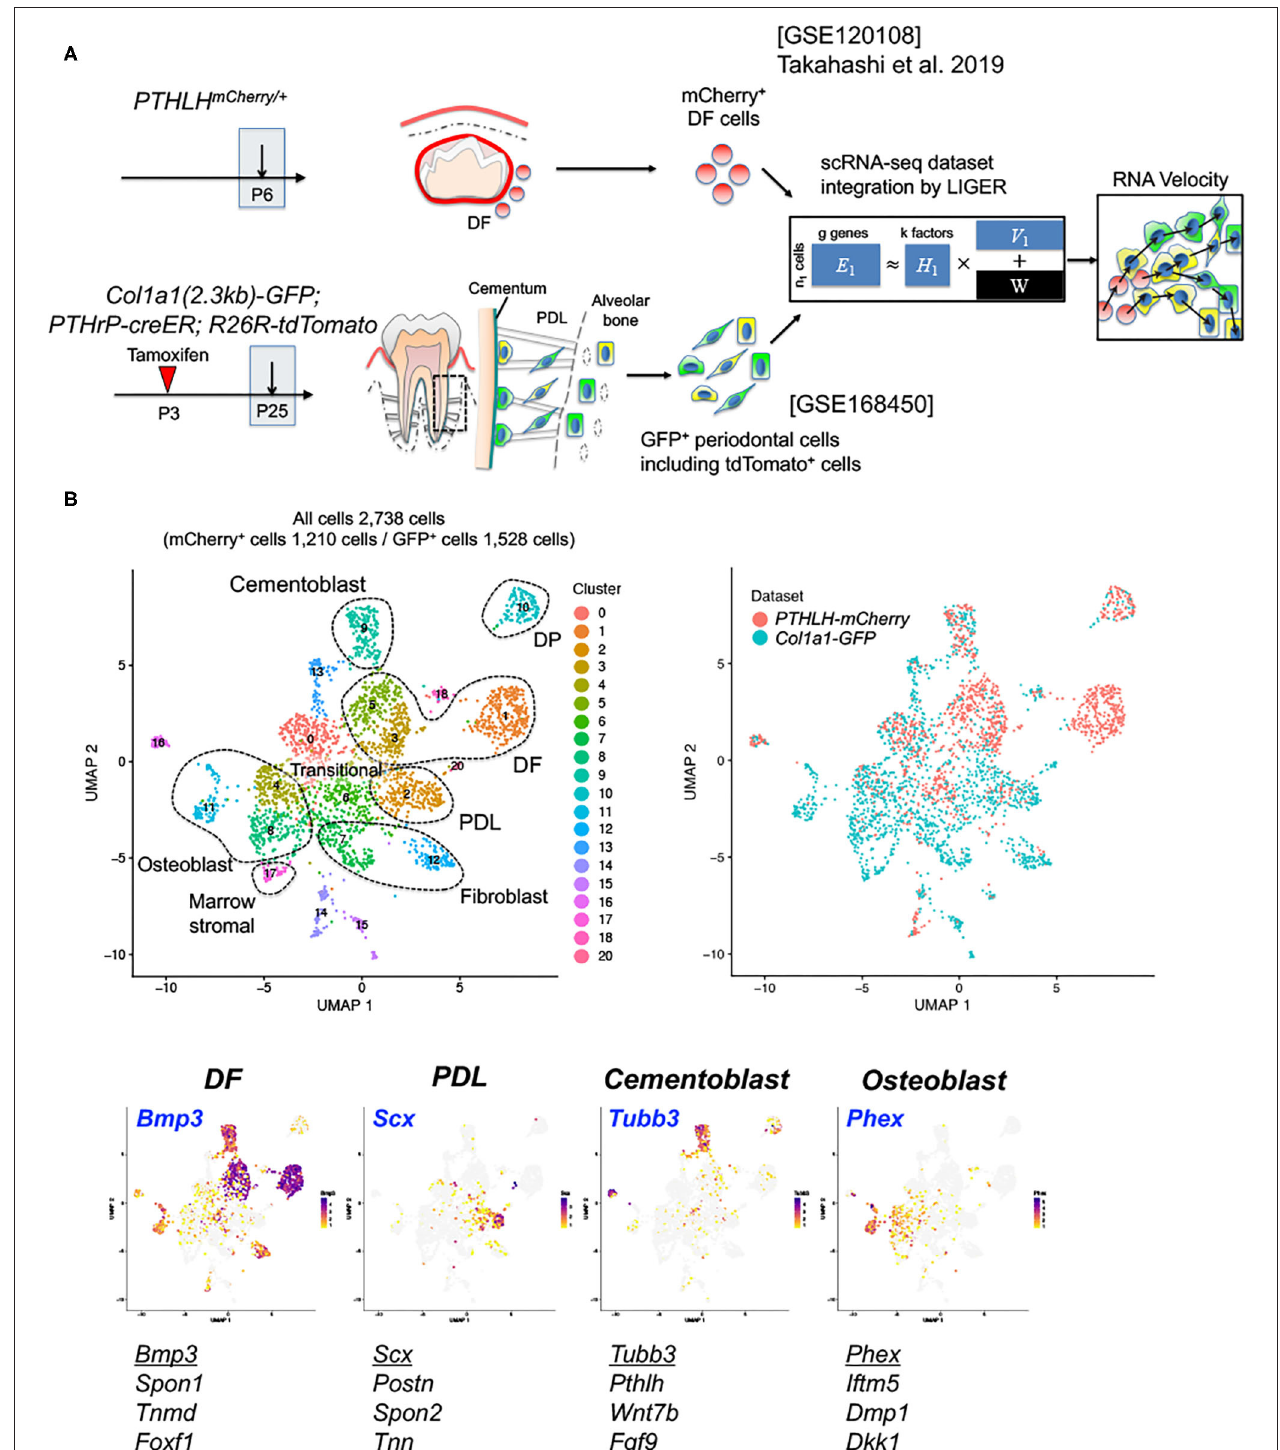
FIGURE 2 | Characterization of PTHrP-mCherry + DF cells and Col1a1-GFP + periodontal cells. (A) Overview of the scRNA-seq analysis workflow. PTHrP-mCherry + cells at P6 and Col1a1-GFP + periodontal cells at P25 were harvested, and LIGER takes two single-cell datasets, GSE120108 and GSE168450 as input. We integrated single-cell datasets using LIGER and performed RNA velocity analysis. (B) UMAP-based visualization of major classes of FACS-sorted cells; dots indicate individual cells. Left upper panel: cells colored by LIGER clustering. Right upper panel: cells colored by sample. Feature plot of cell-type specific markers. High expression: violet, Low expression: yellow, No expression: gray. A total of 2,738 filtered cells from two datasets, 1,210 PTHrP-mCherry + cells and 1,528 Col1a1-GFP + cells. DF: dental follicle, DP: dental pulp, PDL: periodontal ligament.